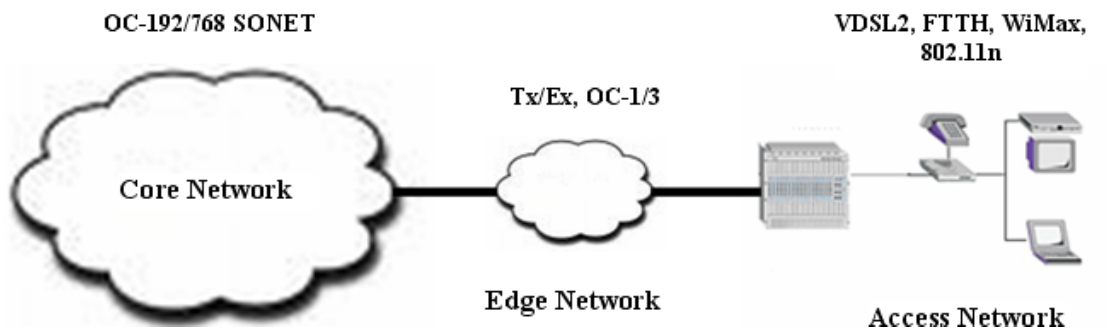
Figure 1. Existence of an edge network